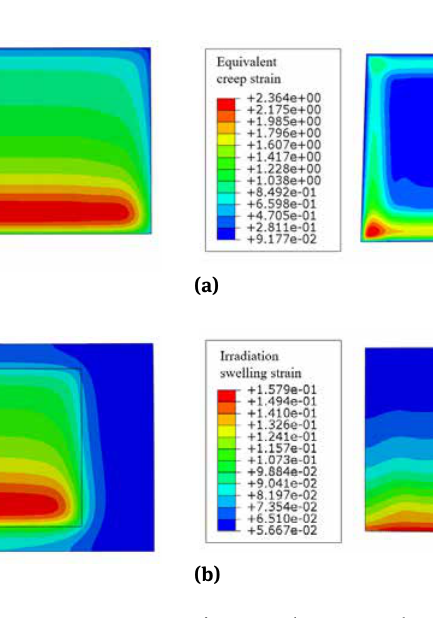
Figure 13: The contour plots of thermal expansion strains on the 98 th day: (a) in the fuel meat; (b) in the cladding